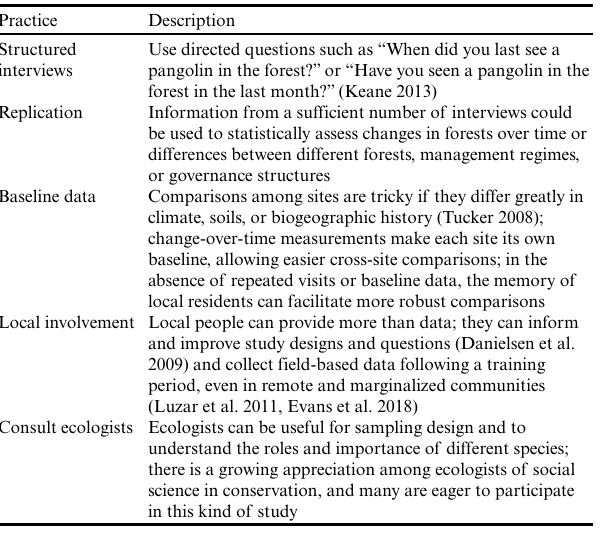
Table 2. Suggested practices for effective nonplot-based monitoring of forest